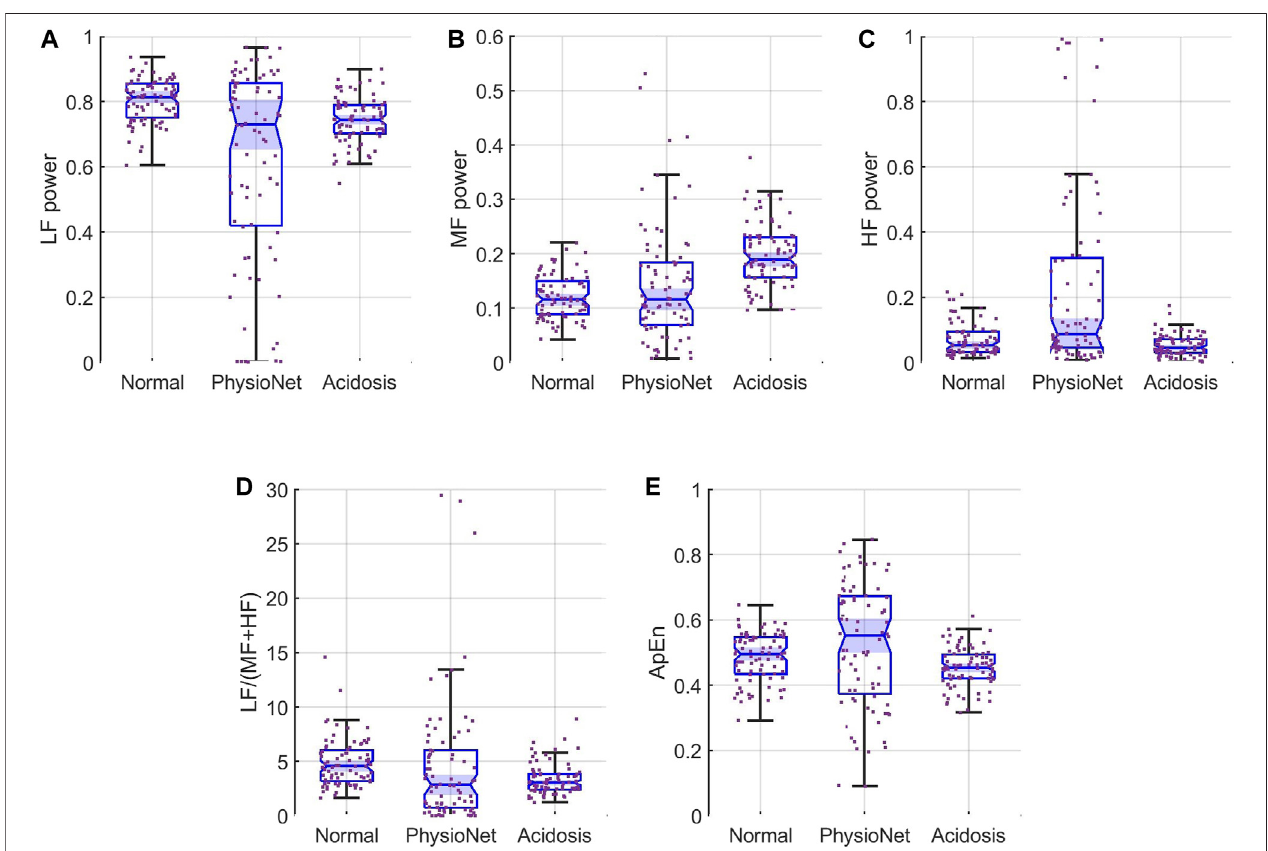
FIGURE5| Featuredistributionsfor (A) LF, (B) MF,and (C) HF (D) LF/(MF+HF)ratio,and (E) ApEn.Eachpanelshowthesamples(scatteredpoints)andboxplots for the features for simulated normal (left), the PhysioNet data (middle), and simulated acidosis FHR RRI features (right). The notches, or indentations, in each boxplot indicate the 95% CI for the median of each distribution. These plots show that the PhysioNet data and the simulated normal are not signi fi cantly different for any of the features. In contrast, the simulated acidosis distributions are signi fi cantly different for the MF and ApEn.